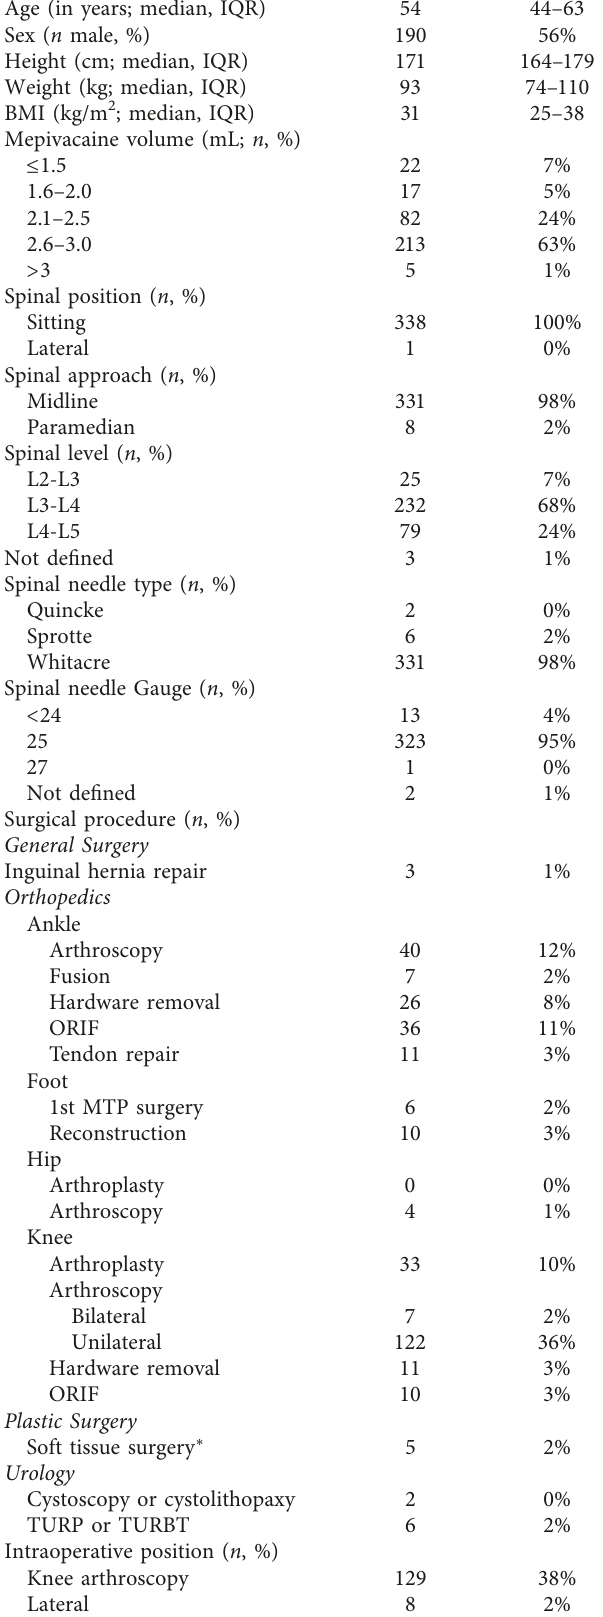
Table 2: Characteristics of excluded records ( n � 339 mepivacaine spinal